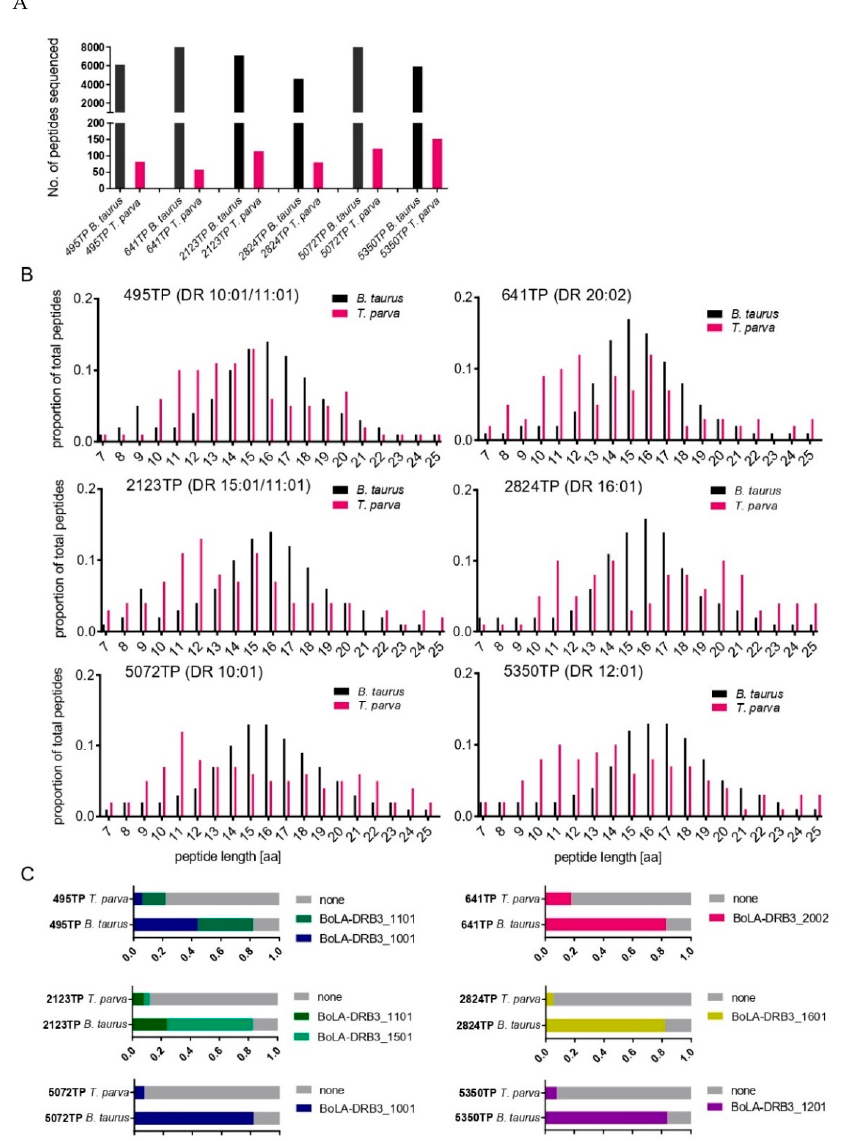
Figure 6. Characteristics of BoLA-DR eluted peptides from 2123TP (BoLA-DR 15:01/11:01), 2824TP (BoLA-DR 16:01), 5072TP (BoLA-DR 10:01), 641TP (BoLA-DR 20:02), 495TP (BoLA-DR 10:01/11:01), and 5350TP (BoLA-DR 12:01) cell lines. ( A ) Number of B. taurus and T. parva peptide sequences identified in each sample. ( B ) Length distributions of B. taurus and T. parva peptides identified in each sample. The horizontal axis shows the length of peptides, and the vertical axis shows the proportion of the peptides identified for each length. ( C ) Binding predictions of B. taurus and T. parva 13–21-mer peptides stratified by their predicted BoLA-DR allele of origin (peptides with a rank-predicted binding score of <5% to a BoLA-DR allele were considered to be binders). Peptides predicted to be MHC-binders are represented by coloured blocks, peptides predicted to be non- MHC binders are represented by grey blocks; the size of the blocks is proportional to the number of peptides in the respective datasets.